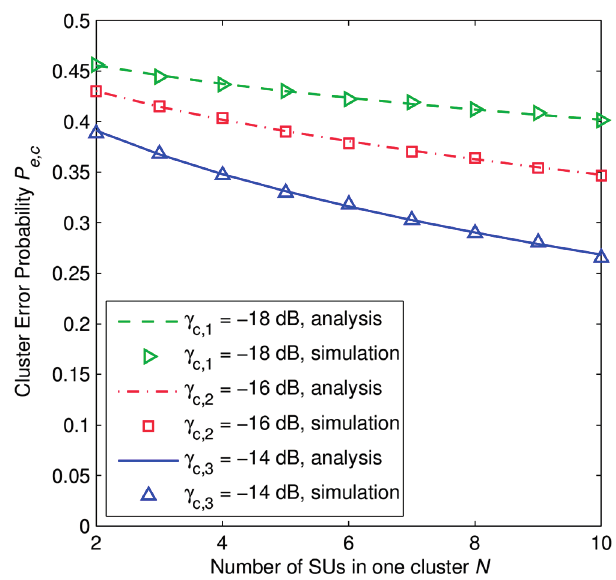
Figure 4. Error probability at a cluster head P e,c as a function of number of SUs in one cluster N with P 1 = P 0 = 0.5, M = 50